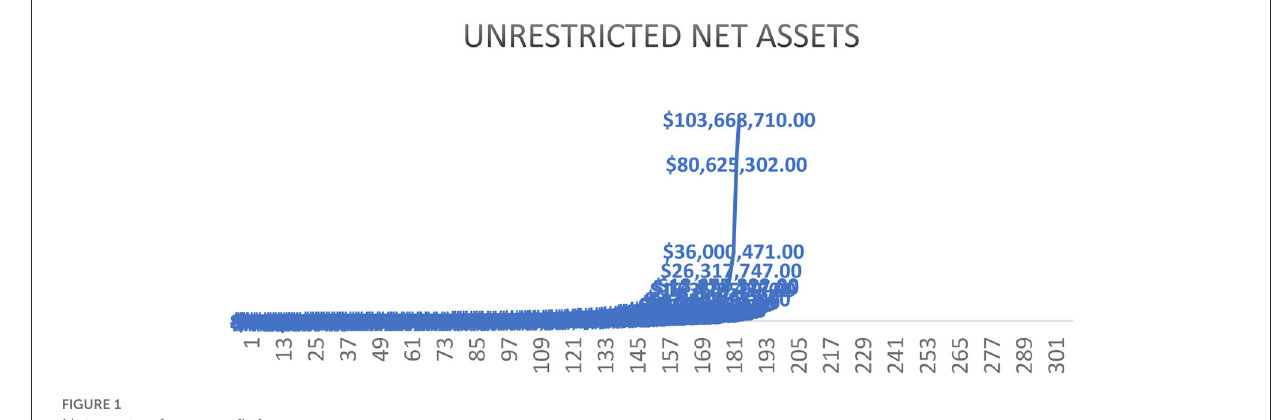
FIGURE1 Net assets of non-profit farms.